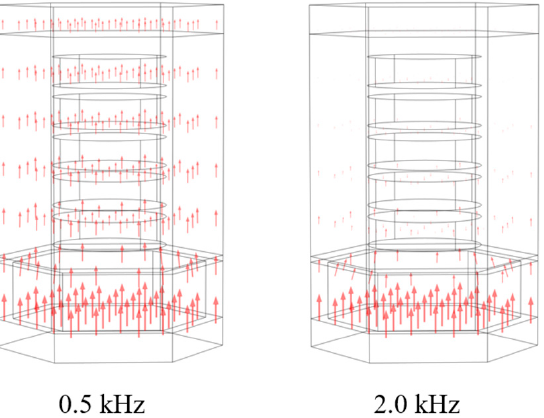
Figure 7. Depiction of the particle velocity vector in the backward incidence at two different fre-